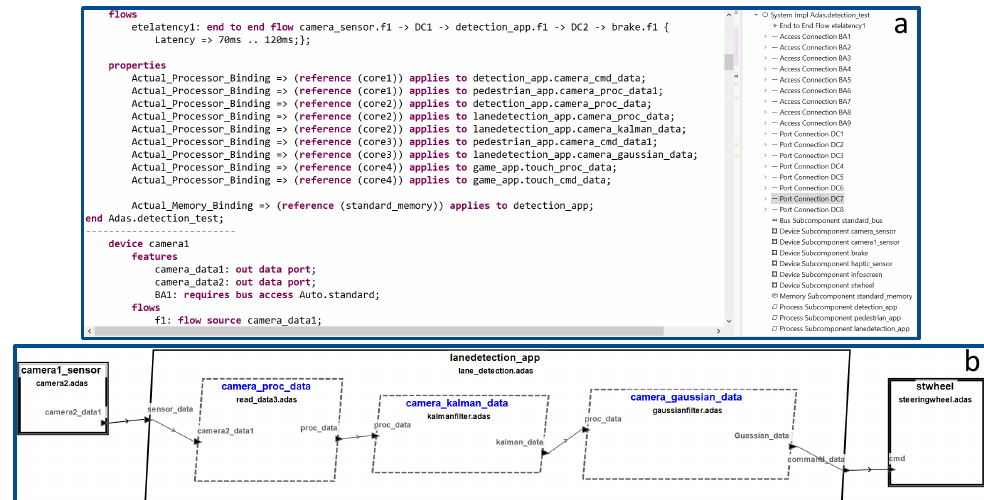
Figure 4. The AADL text editor ( a ) to synchronized graphical editor ( b ) in OSATE